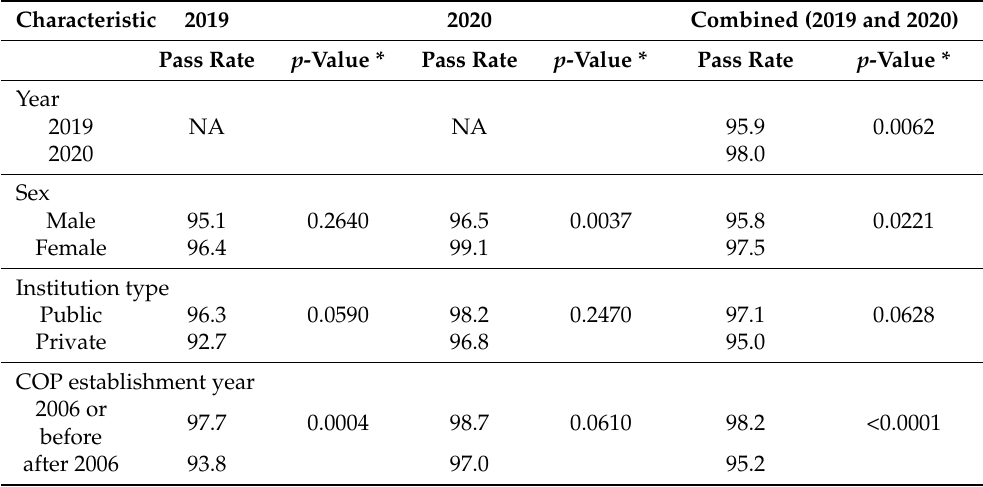
Table 2. SPLE first-time pass rates per applicant and institution characteristics.